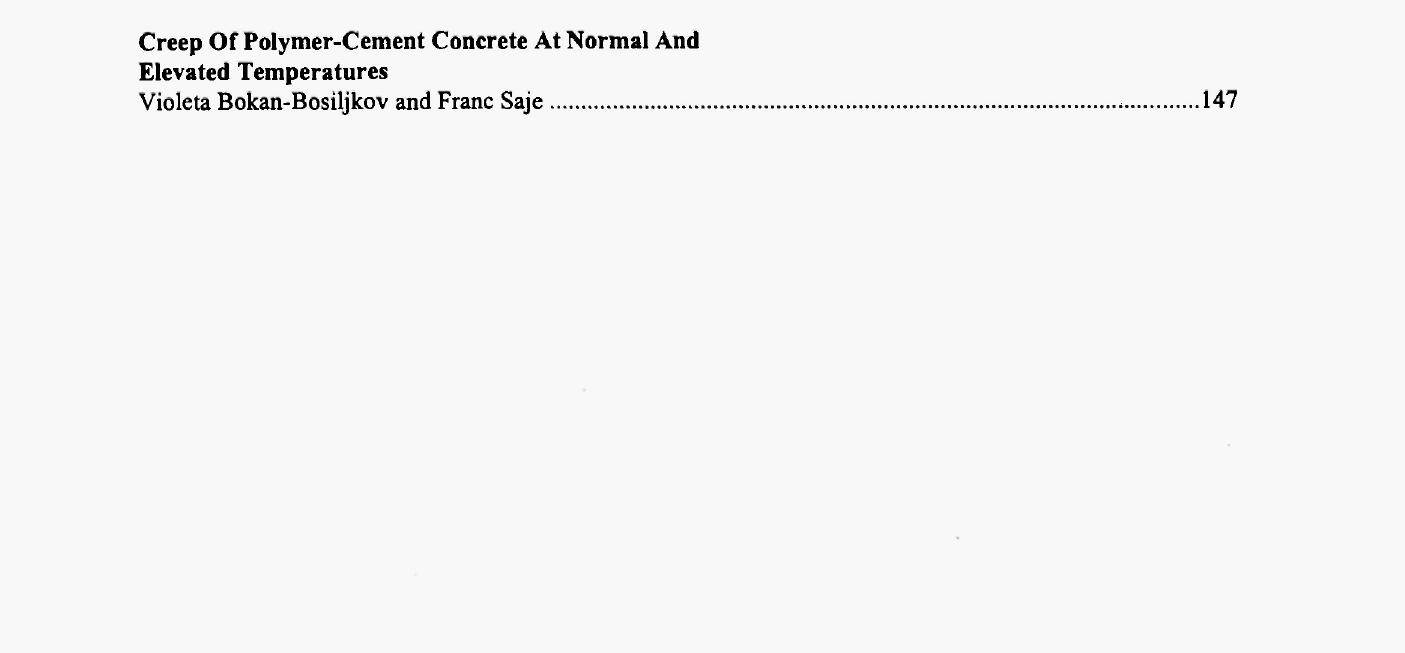
Deformation Twinning in Cd Single